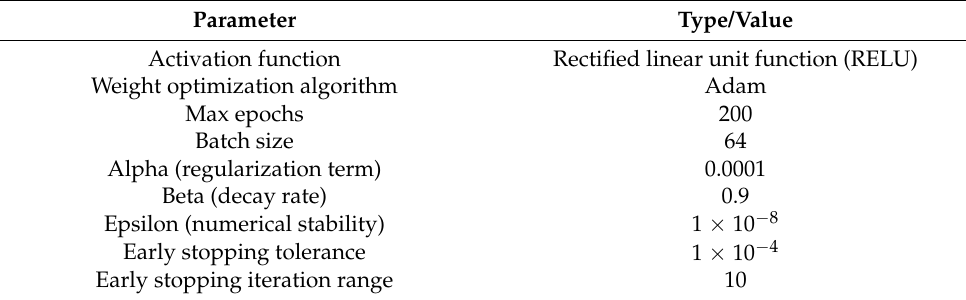
Table A4. MLP hyper parameter